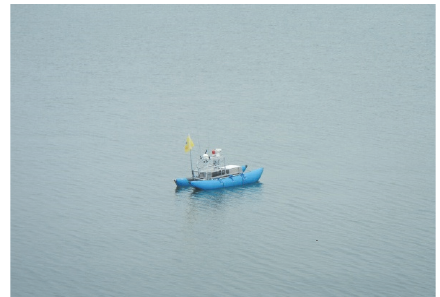
Figure 5: Our USV in the lake experiment.